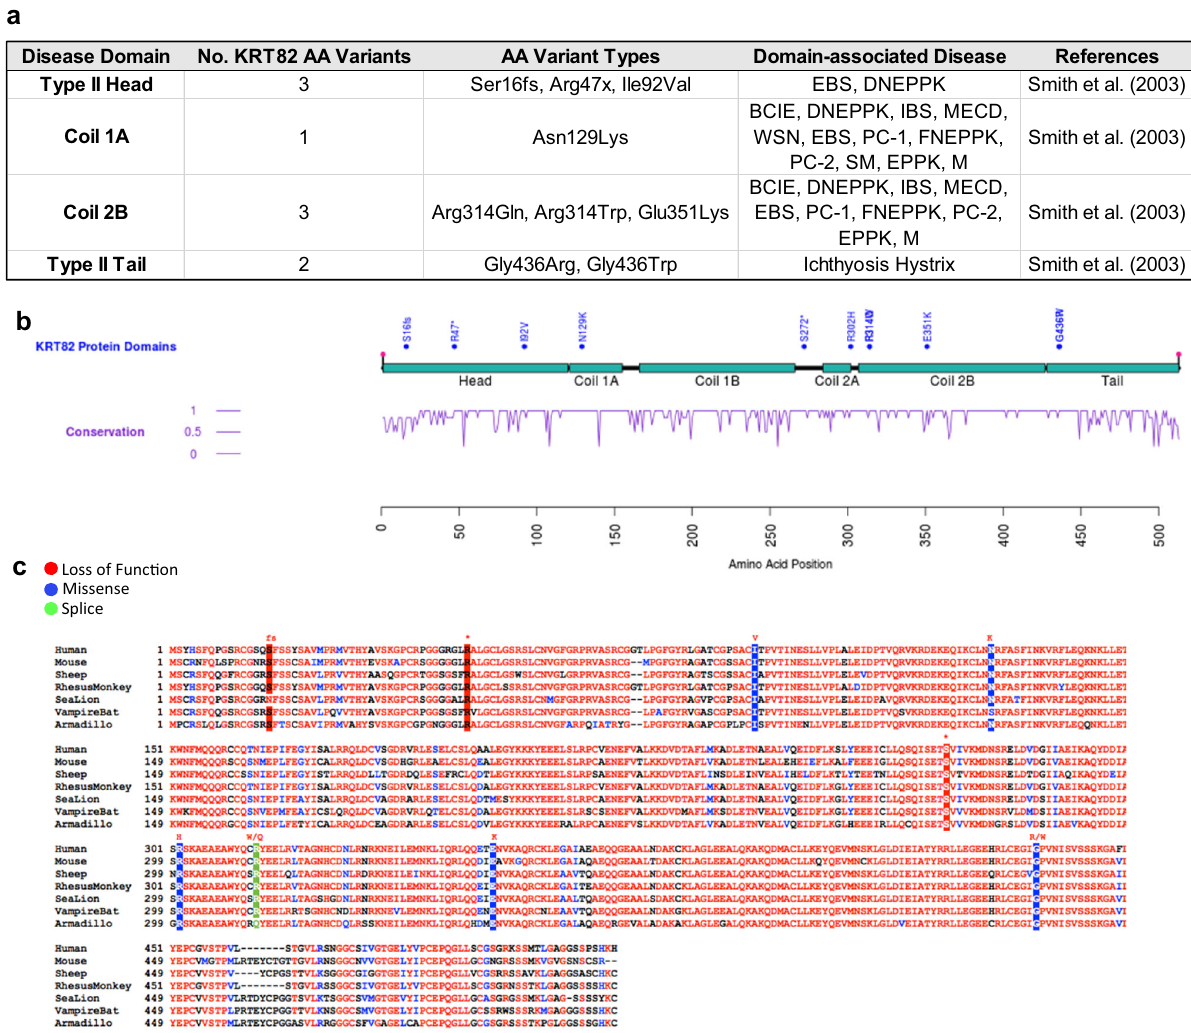
Fig. 2 KRT82 variants are localized to highly conserved disease-annotated domains. a Table of 9 of the KRT82 damaging variants that fall in a domain previously associated with pathogenic keratin variants in other diseases. b schematic representation of KRT82 with domains (turquoise), AA variants (blue), and conservation score (purple) (1 = highly conserved). c Conservation of KRT82 amino acids across 7 different species: human, mouse, sheep, rhesus monkey, sea lion, vampire bat, and armadillo. AA variants are highlighted in red (LoF), blue (Missense), and green (Splicing). Amino acid change of variant is annotated in red above. EBS = epidermolysis bullosa simplex; CC = Cryptogenic Cirrhosis; DNEPPK = diffuse non-epidermolytic palmoplantar keratoderma; BCIE = bullous congenital ichthyosiform erythroderma; IBS = ichthyosis bullosa of Siemens; MECD = Meesmann ’ s epithelial corneal dystrophy; WSN = white sponge nevus; PC = pachyonychia congenita; FNEPPK = focal non-epidermolytic palmoplantar keratoderma; SM = steatocystoma multiplex; EPPK = epidermolytic palmoplantar keratoderma; M =